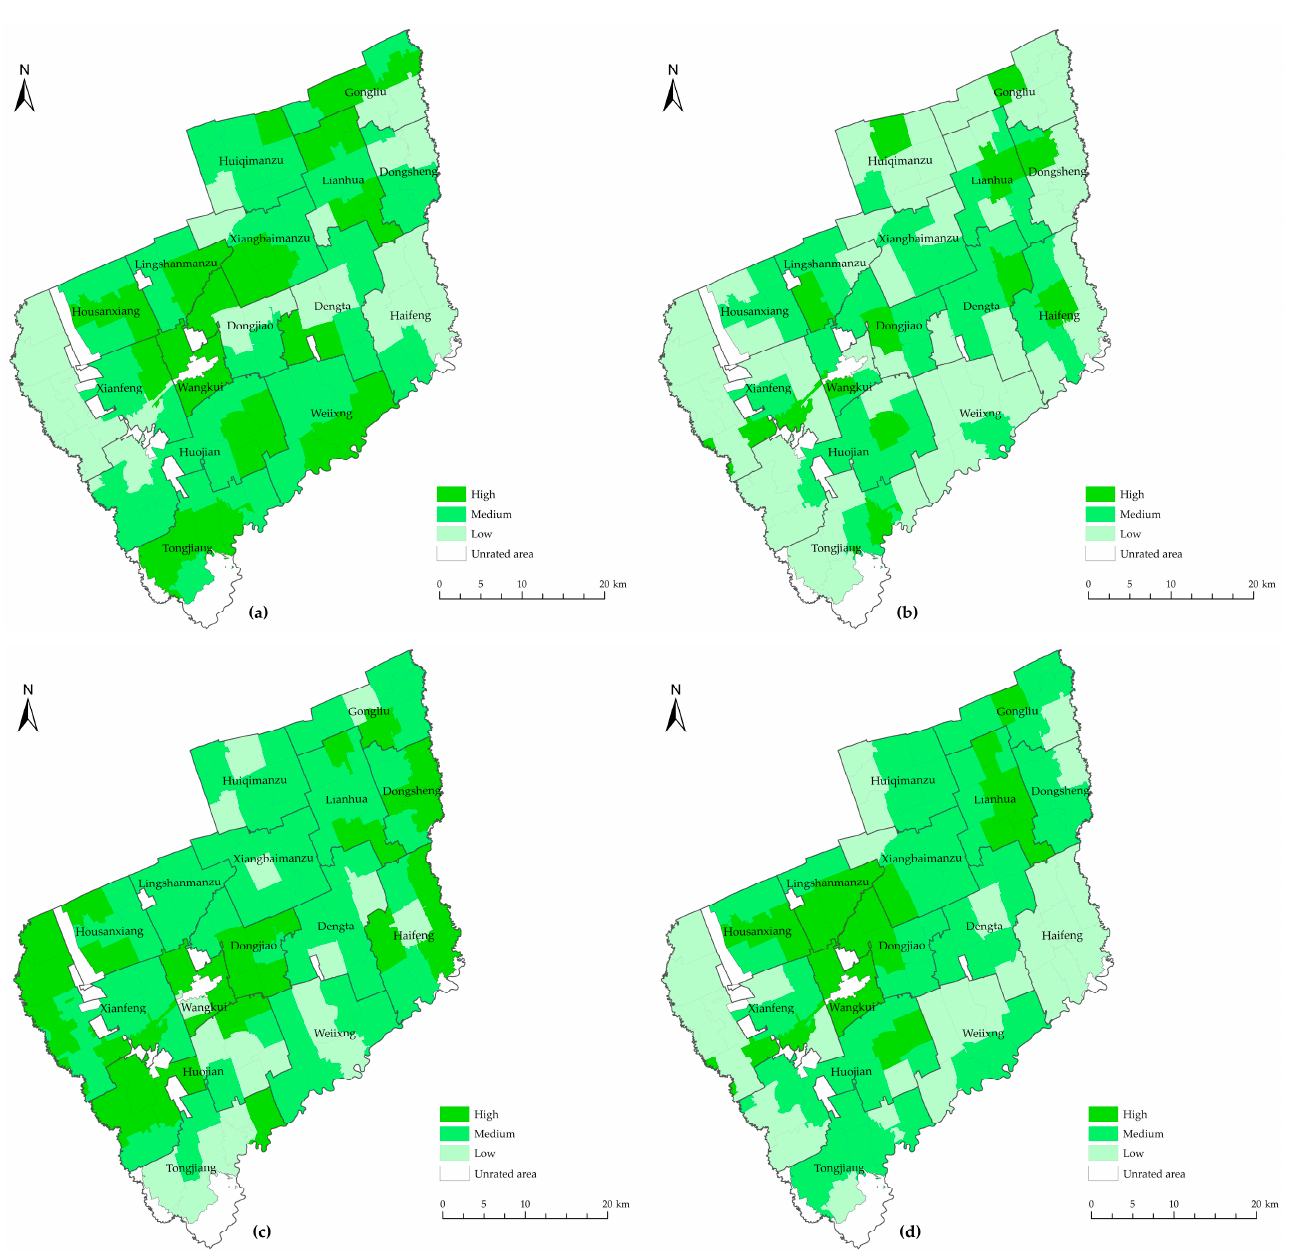
Figure 3. Spatial distribution map of the utilization-quality grades of rural residential areas: ( a ) dis- tribution map of the intensive-land-utilization grades; ( b ) distribution map of the human settlement environment quality grades; ( c ) distribution map of the ecological-environment-quality grades; ( d ) distribution map of the utilization-quality grades.